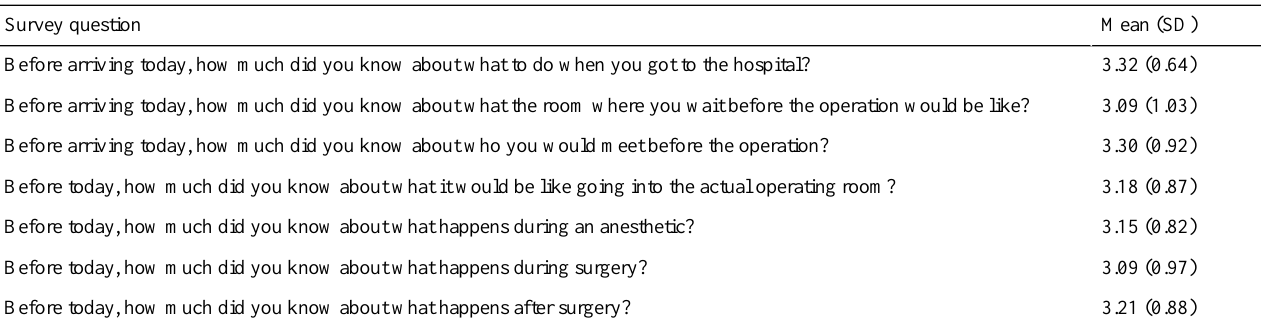
Table 3. Parents’ (n=35) average ratings of how much they knew about the procedure before arriving at the hospital (4-point scale, ranging from 1=“nothing at all” to 4=“everything”).